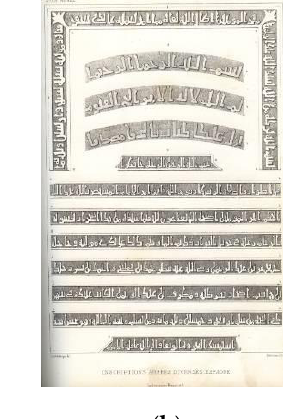
Figure 10. Girault de Prangey: ( a ) Villaviciosa Chapel facade (Bouillon, lit.); ( b ) Section-perspective from the surrounding mihrab (Chapuy, dib.; Asselineau, lit.). Source: Essai sur l’architecture des Arabes et des Mores, en Espagne... 1841.